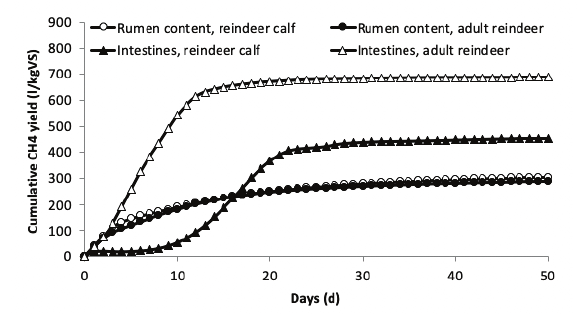
-production curves of agricultural 4